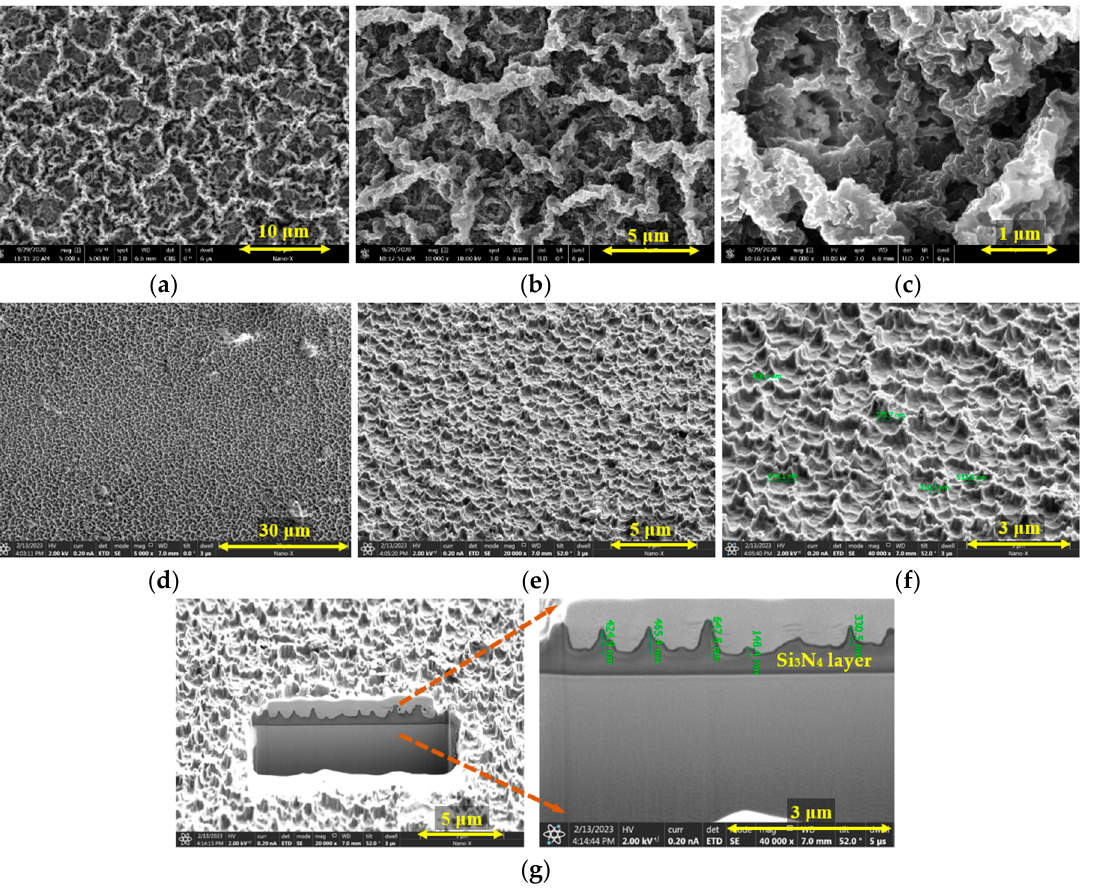
Figure 3. Surface morphologies of carbonized PR: ( a ) 5000 × ; ( b )10,000 × ; ( c ) 40,000 × . Surface mor- phologies of texturized Si 3 N 4 layer: ( d ) 5000 × ; ( e )20,000 × ; ( f ) 40,000 × . Cross-sectional morphologies of texturized Si 3 N 4 layer: ( g ) 40,000 ×